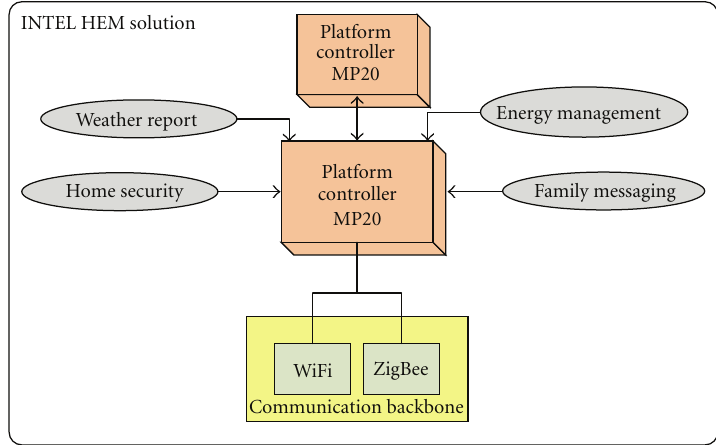
Figure 7: Intel HEM